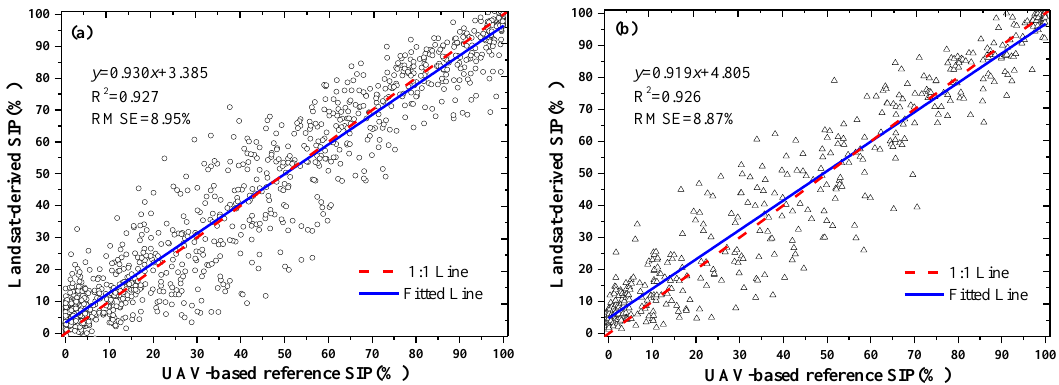
Figure 9. The R 2 and RMSE of the relationships between the reference SIP and Landsat-predicted SIP, under ANN in 2014 for the: training data ( a ); and validation data ( b ). The red dotted lines are the 1:1 lines, and the blue solid lines are linear regressions between the predicted and UAV-based reference SIP.